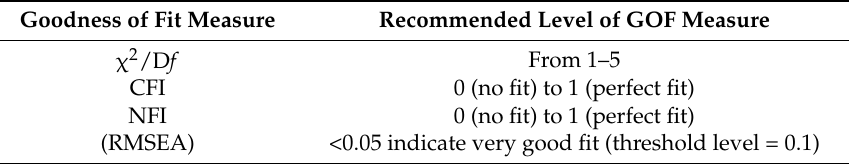
Table 4. The recommended level of goodness‐fit (GOF) measures. CFI, comparative fit index; NFI, normal fit index.